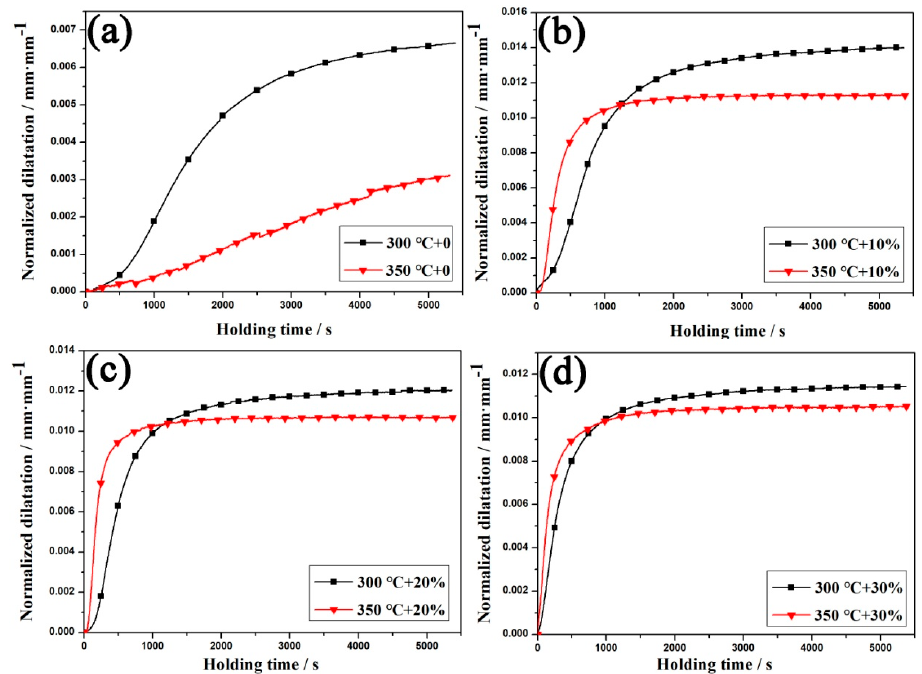
Figure 5. Normalized dilatation representing the amount of bainitic transformation during isothermal holding: ( a ) nondeformed samples; deformed with a strain of ( b ) 0.1; ( c ) 0.2; and ( d ) 0.3.